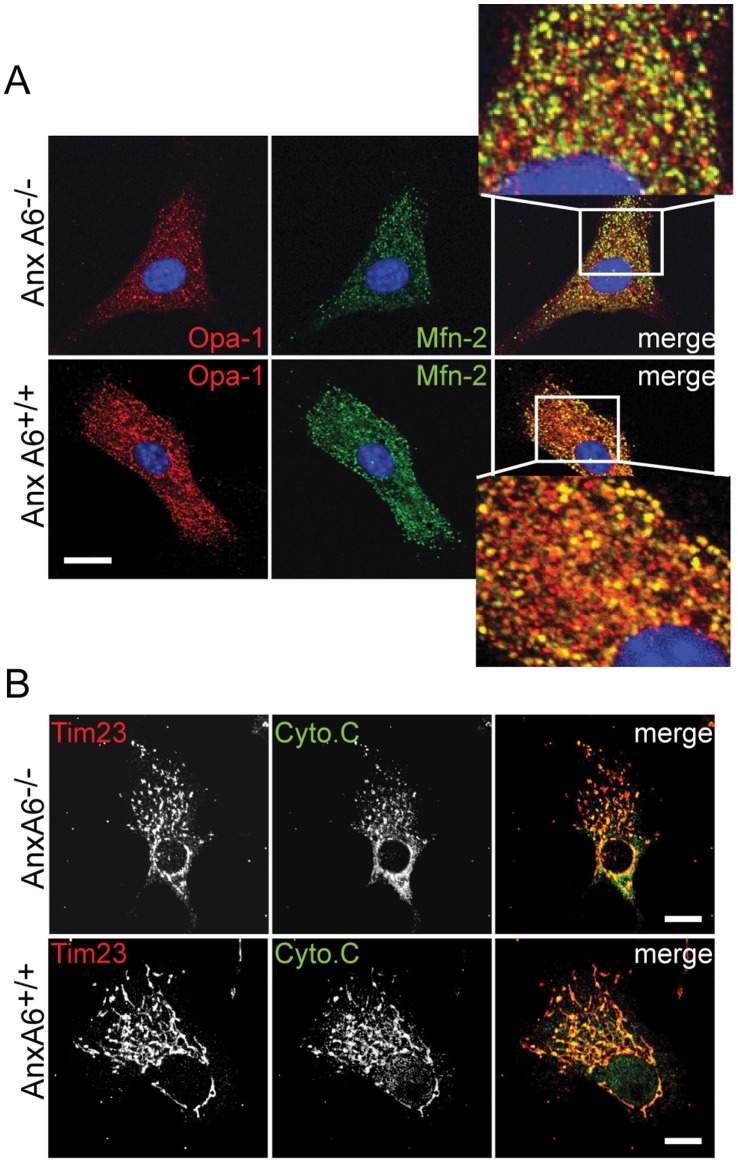
Loss of mitochondria-ER contact sites in AnxA6
−/− cells.(A) Opa-1 and Mfn-2 co-localization in AnxA6+/+ and AnxA6−/− fibroblasts mark the overlap between ER and mitochondria in the two cohorts of cells. Scale bar = 4 µm. (B) Primary mouse fibroblasts fixed and immunostained for Tim23 and Cyto-c The images show co-localisation of Tim23 and Cyto-C in fibroblasts from both mutant and wild type mice, but with the characteristic mitochondrial fragmentation in AnxA6 null cells. Scale bar = 5 µm.